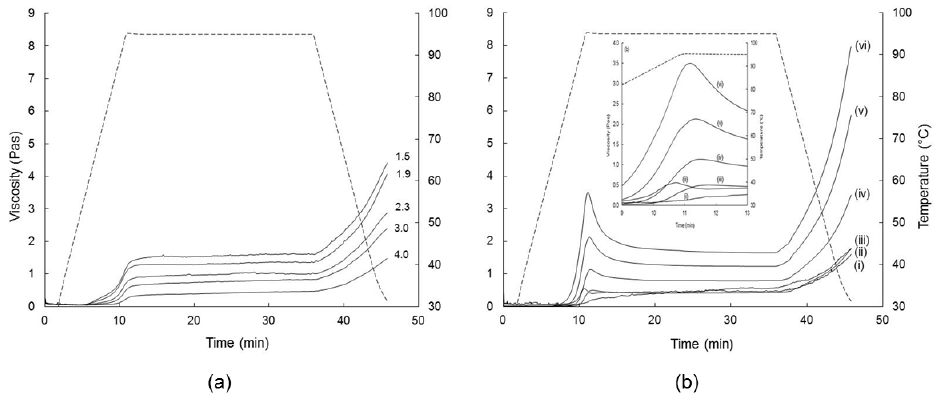
Figure 4. Pasting curves of reconstituted ( a ) unsalted fermented milk–wheat composites (FMWC) with different ratios of fermented milk to wheat: 1.5, 1.9, 2.3, 3.0, or 4.0, as shown; and ( b ) non-parboiled wheat (i), parboiled wheat (ii) and native wheat starch at levels of 6 (iii), 7 (iv), 8 (v), or 9 (vi) %, as shown. The broken line (----) shows temperature, while the inset in (b) shows the changes after heating to 95 °C in more detail.